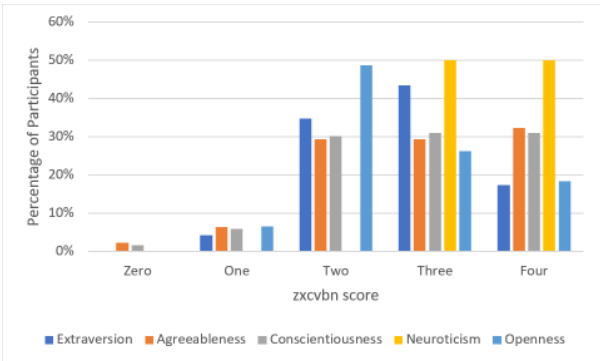
Figure 2. MTurk survey: zxcvbn password scores for each Big Five personality